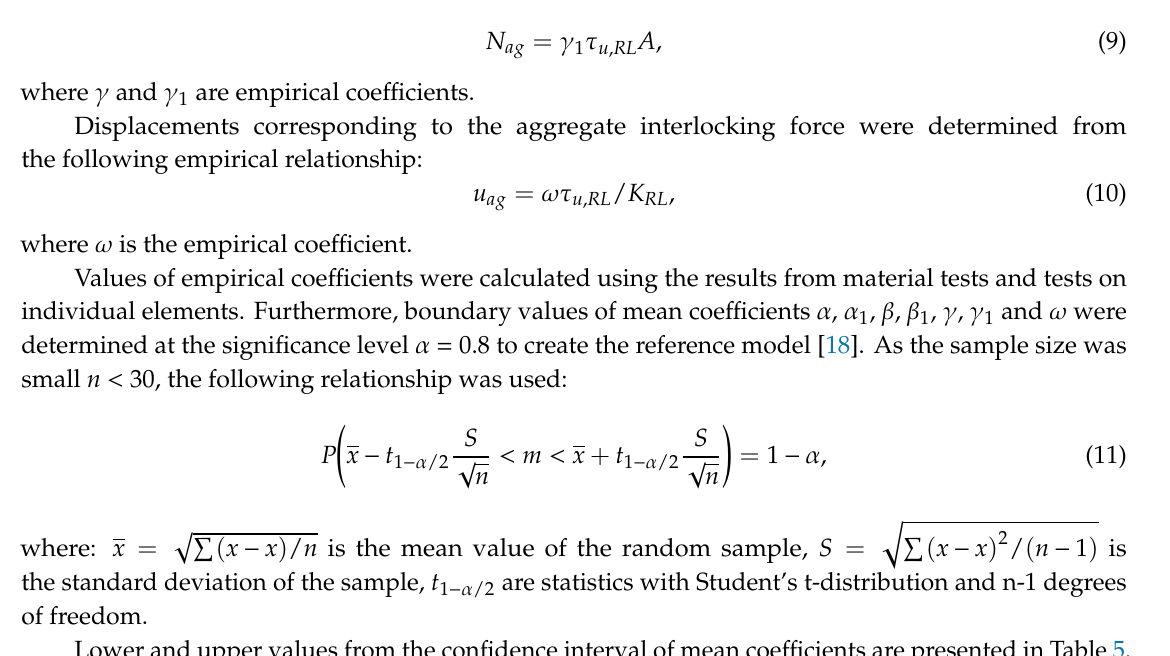
Table 5. Validation of empirical coe ffi cient of the model with unreinforced wall joints.